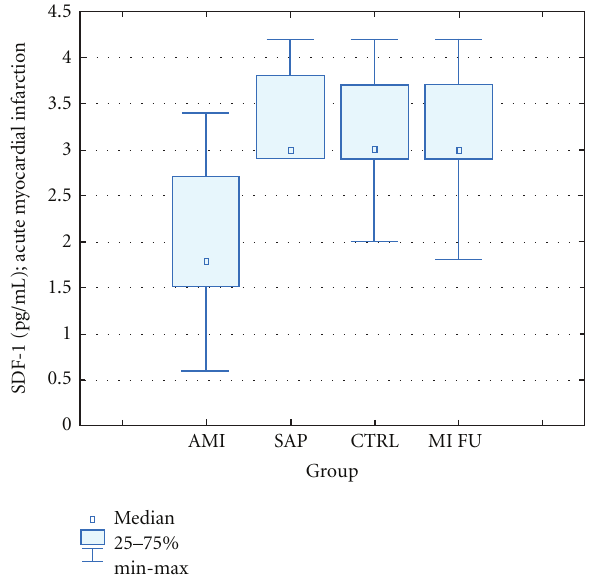
Figure 2: PlasmaSDF-1 levels. AMI: acute myocardial infarction, SAP: stable angina pectoris, CTRL; control group, MI FUL: 1-year followup. Data is presented as cell number in 1 μ L of peripheral blood (median ± IQR).